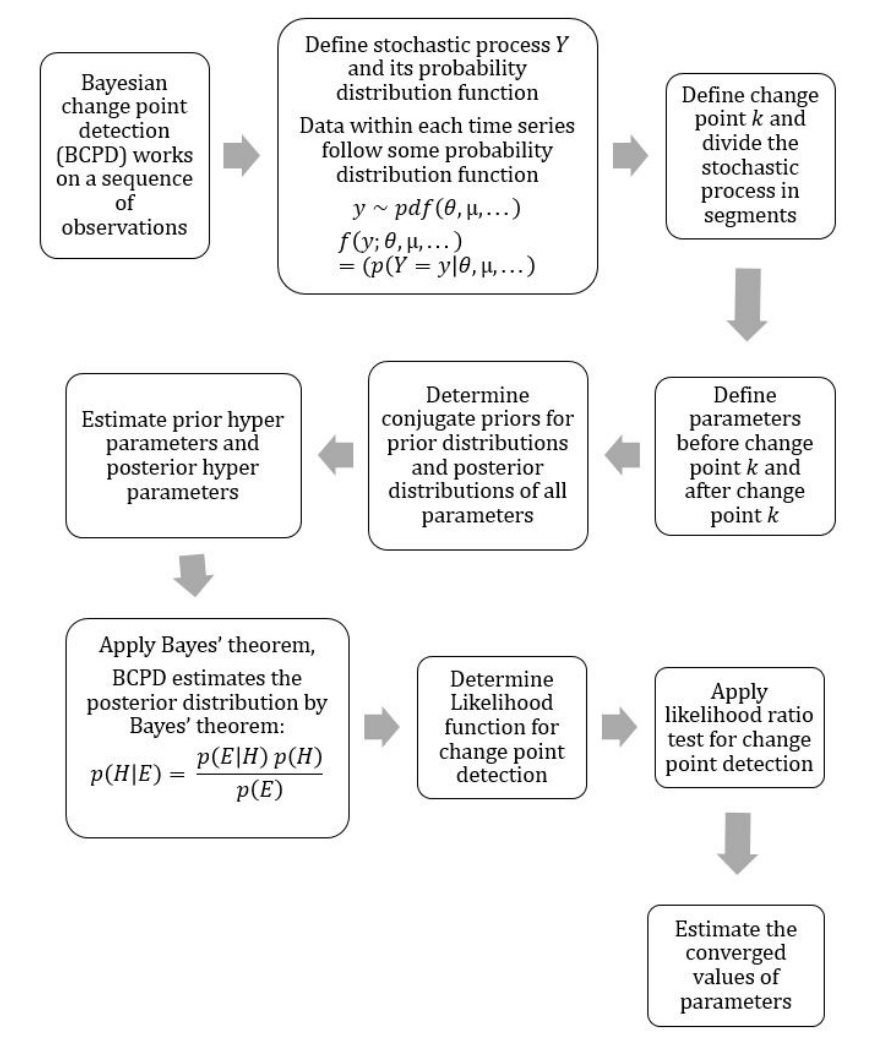
Figure 1. Flowchart for change point ( k )